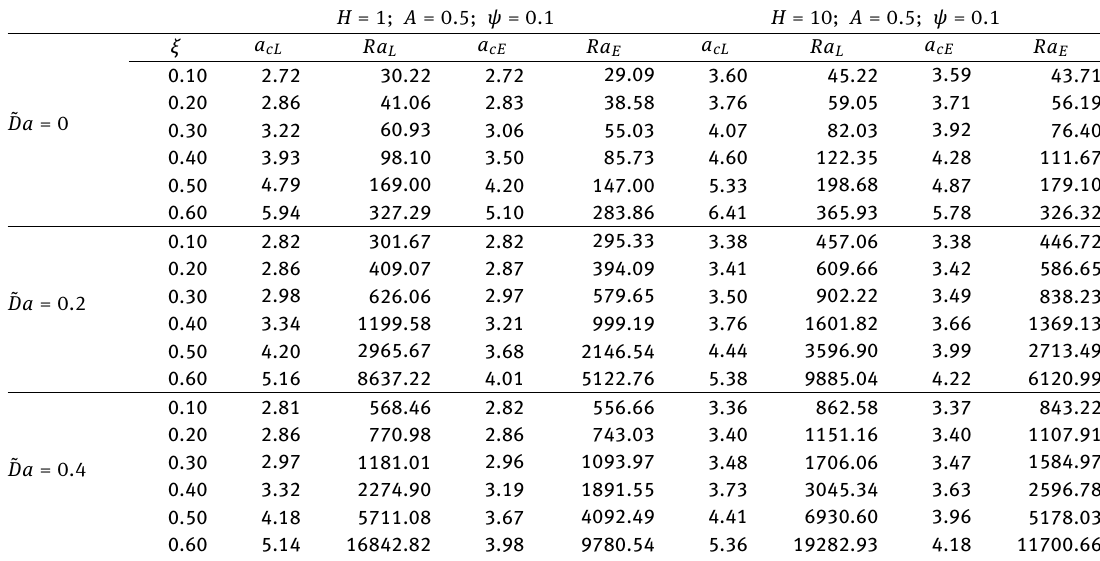
Table 2: variation of critical Rayleigh number ( Ra L , Ra E ) with internal heat parameter ( ξ ) at fixed values of ˜ Da , H , A , ψ for case A of the constant heat source